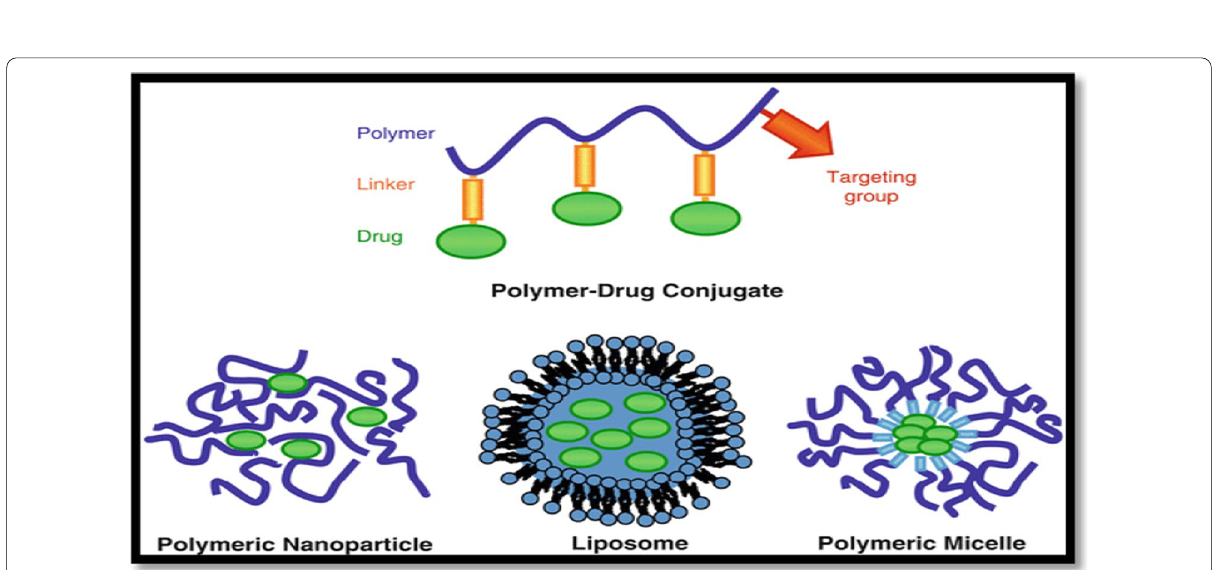
Fig. 8 Schematic representation of polymer drug conjugates [19,